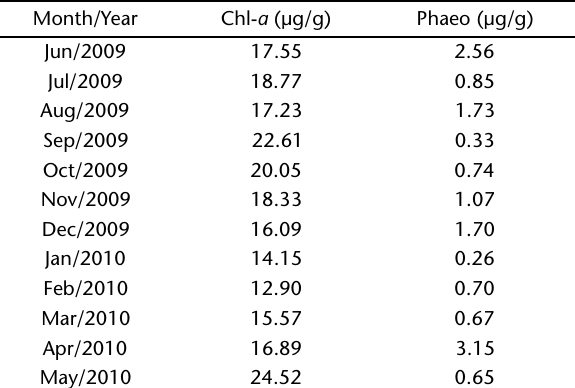
Table III. Concentrations of chlorophyll- a (Chl- a ) and phaeo- pigments (Phaeo) in the surface layer of the sediment from the Manguinhos beach, between June 2009 and May 2010.